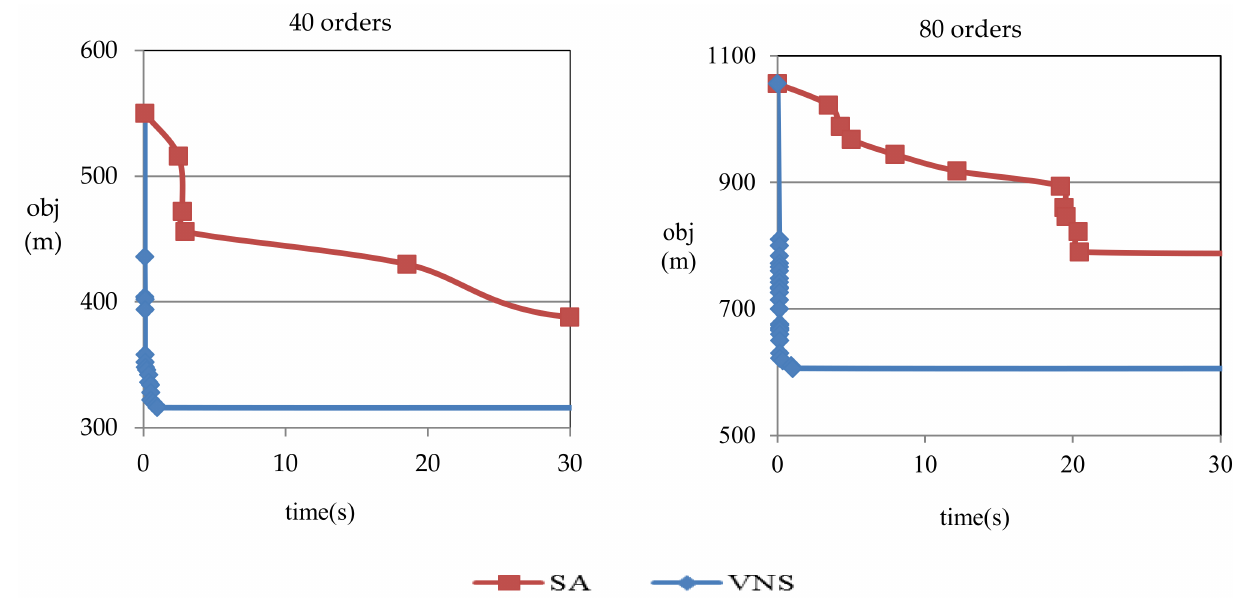
Figure 5. Computation time trends of 40 and 80